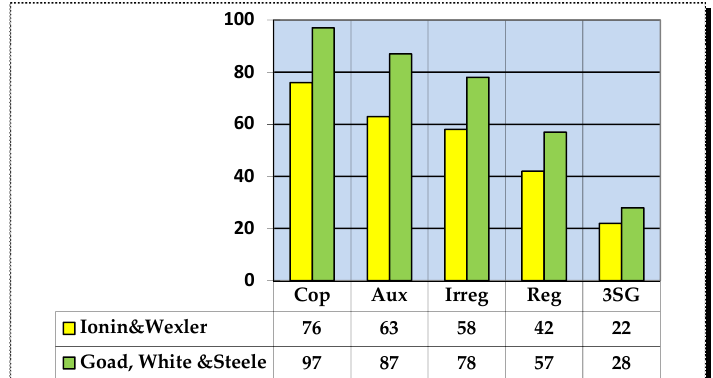
Figure 1. Accuracy rates of English verbal morphology in obligatory contexts (%).